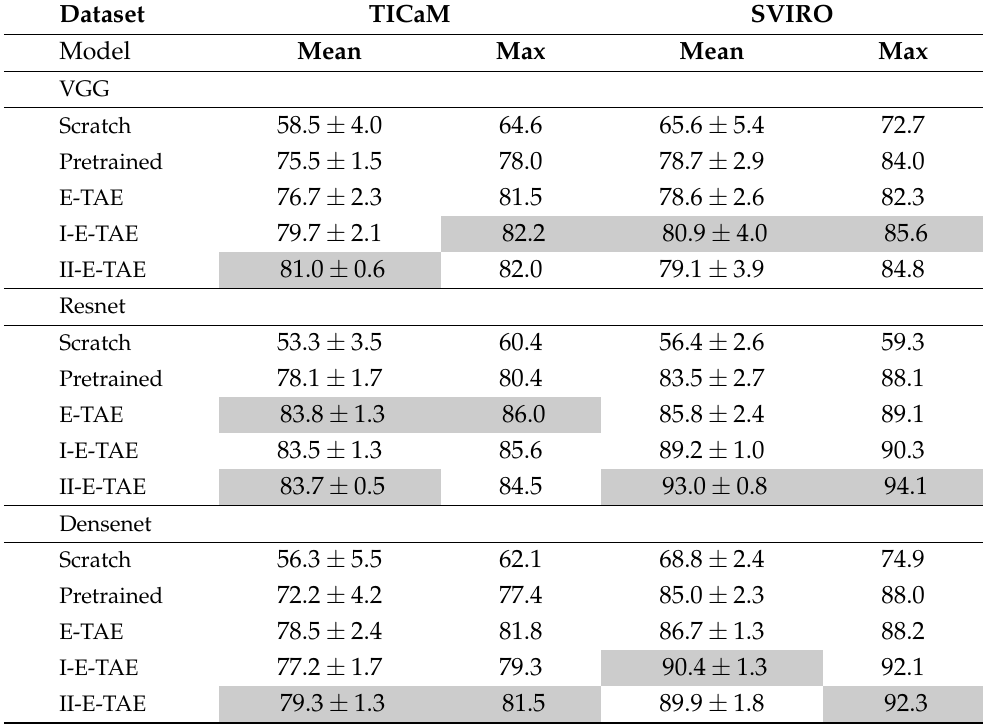
Table 3. For each experiment, the best performance on real vehicle interior images (TICaM) across all epochs is taken and then the mean and maximum of those values across all 10 runs is reported. The model weights achieving maximum performance per run are evaluated on SVIRO, where they perform better as well. We used the triplet loss (TAE), the first (I) or the second variation (II) of the PIRL and the extractor module (E).